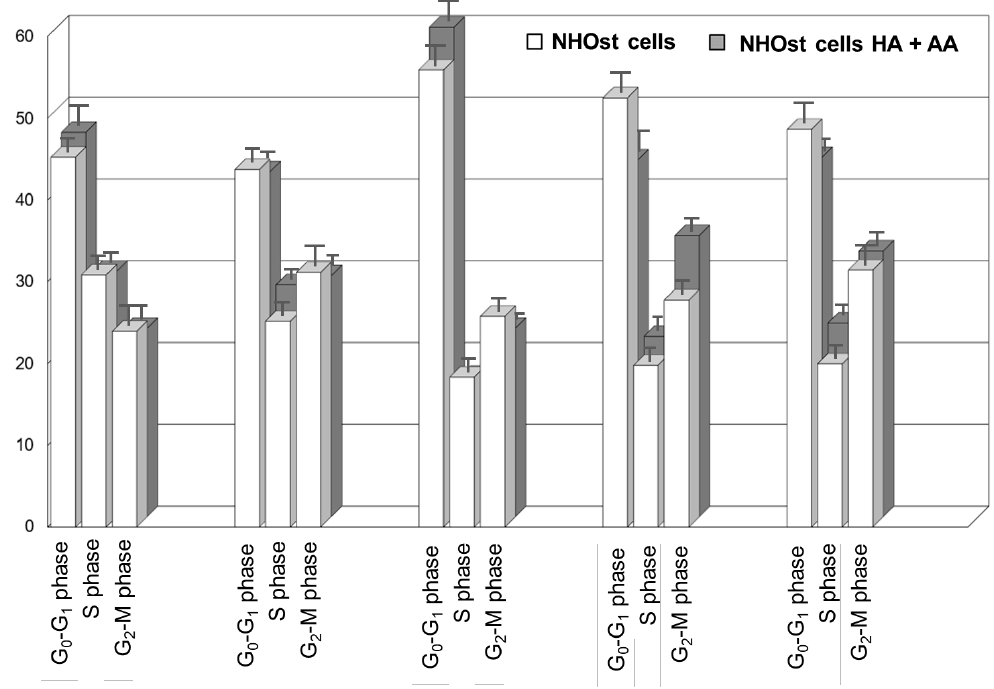
Figure 2. Cell cycle analysis resulting from flow cytometry experiments relevant for untreated NHOst cells and for NHOst cells exposed to HA+AA.